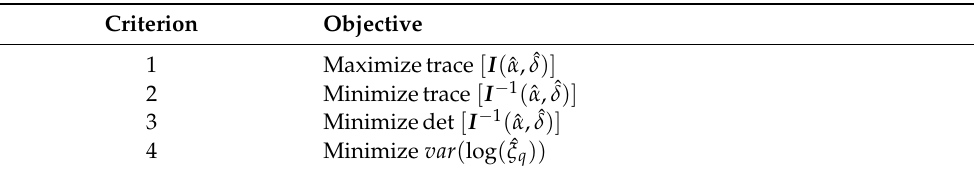
Table 1. Some optimal